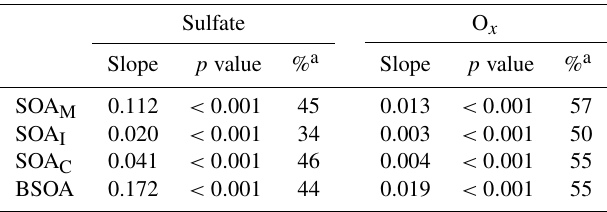
Table 2. Correlations of BSOA with sulfate and O x